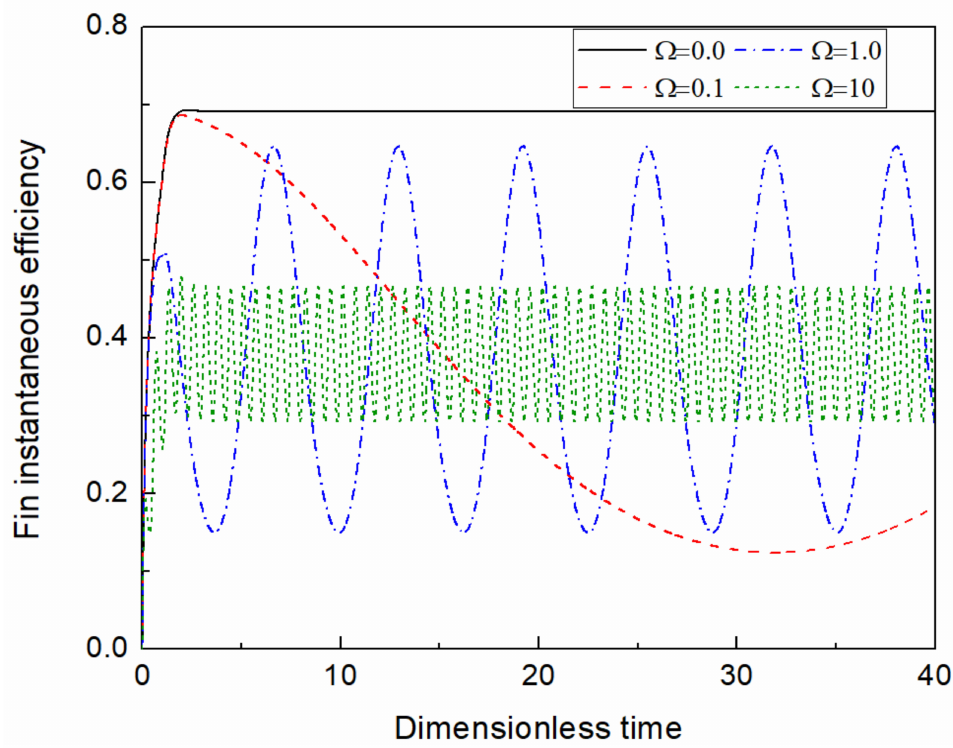
Figure 9. The variation of instantaneous fin efficiency at different values of Ω